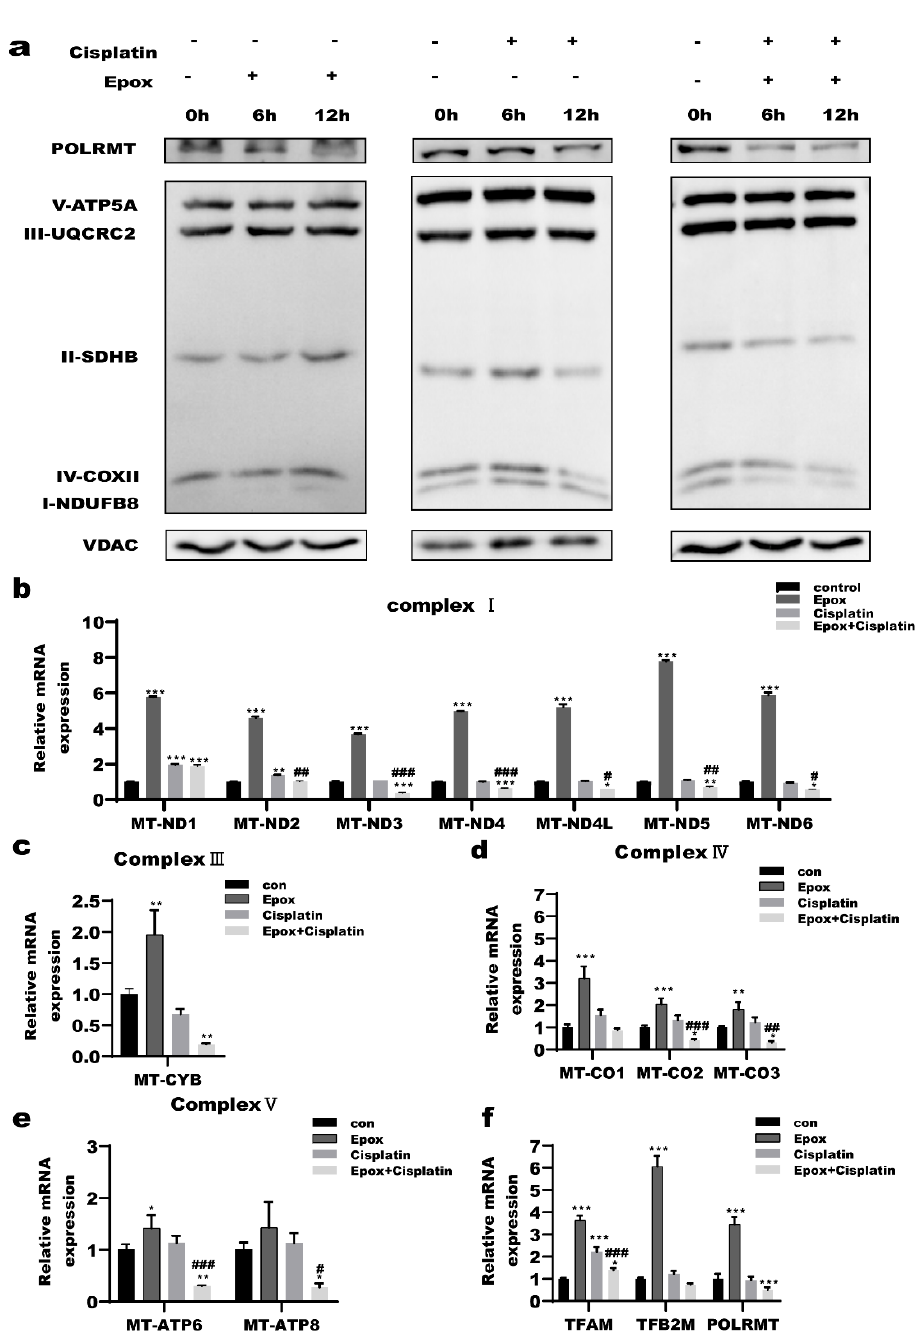
Figure 3. Inhibition of the proteasome pathway affected the expression of respiratory chain subunits in ovarian cancer cells. ( a ) A2780 cells were treat with cisplatin (2 µg/mL) or epox (100 nM) or both for 3, 6, 12 h. Western blot analysis of mitochondrial subunits and mitochondrial RNA polymerase (POLRMT) levels. ( b – e ) A2780 cells were treat with cisplatin (2 µg/mL) or epox (100 nM) or both for 12 h. Quantitative RT-PCR detection of mtDNA-encoded respiratory chain subunits and ( f ) mitochondrial DNA transcription complex mRNAs level. * p < 0.05 vs. con, ** p < 0.01 vs. con, *** p < 0.001 vs. con, # p < 0.05 vs. Cisplatin, ## p < 0.01 vs. Cisplatin, ### p < 0.001 vs. Cisplatin.